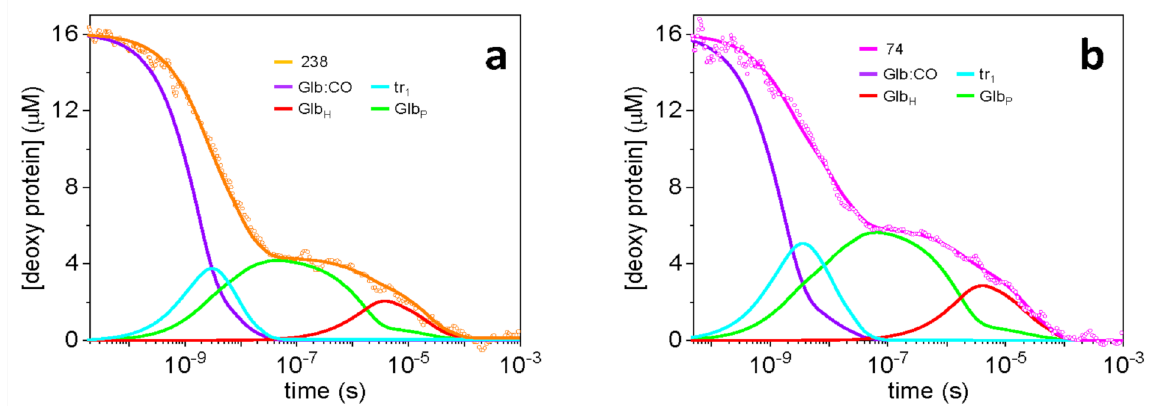
Figure 4. Analysis of CO rebinding kinetics to the ( a ) 238 and ( b ) 74 mutants at room temperature, 1 atm CO. The fitting curves are superimposed on the experimental data (open circles). The time course of the relevant species shown in the kinetic scheme (Scheme 1) are reported: Glb:CO (violet), (tr) 1 (light blue), Glb H (red) and Glb P